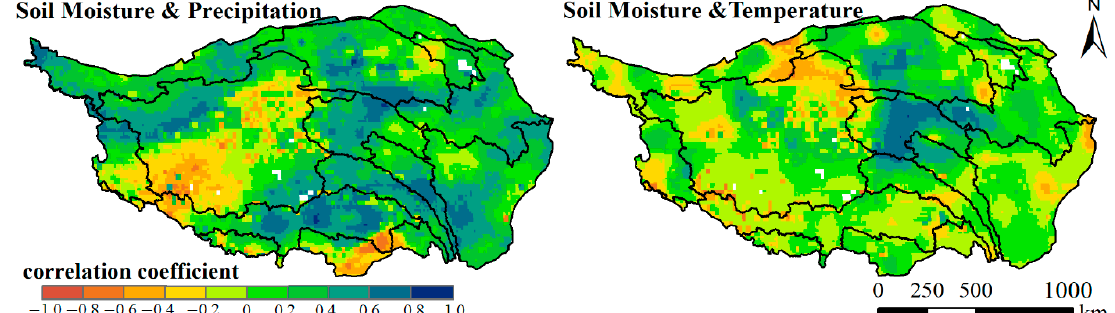
Figure 10. Spatial distributions of correlation coefficients between soil moisture and precipitation, temperature.